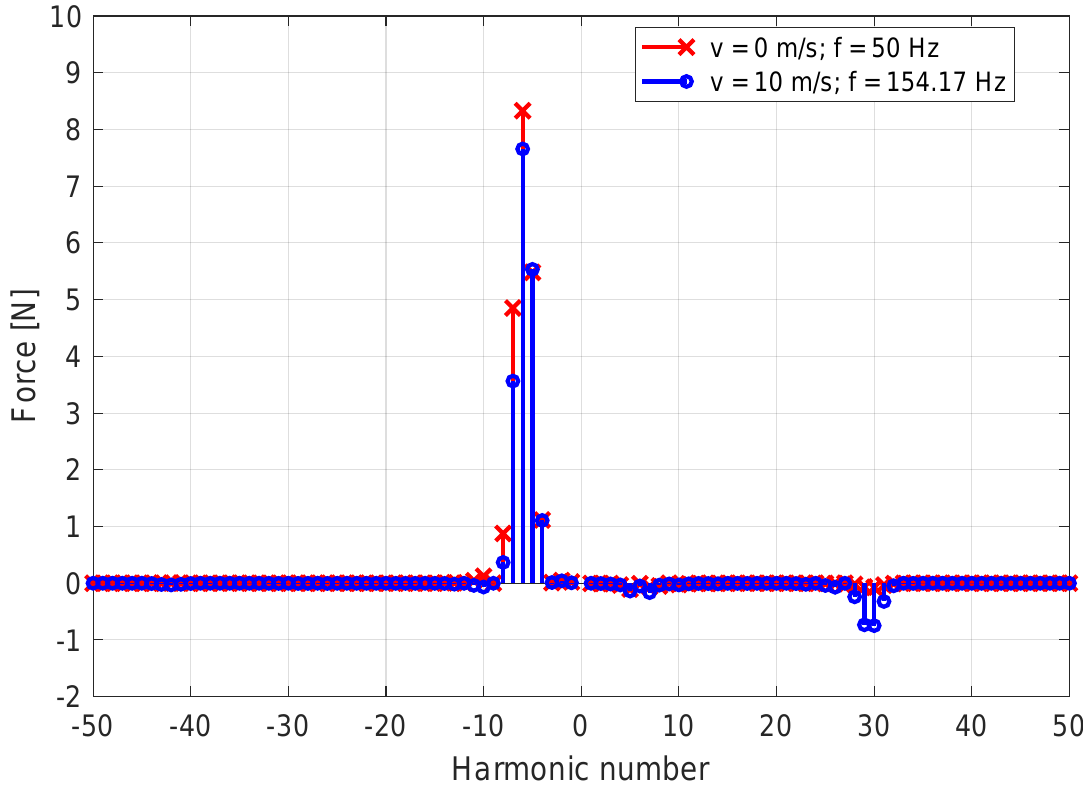
Figure 10. Harmonics contributing to the propulsion force at v = 0 m/s; f = 50 Hz and v = 10 m/s; f = 154.1667